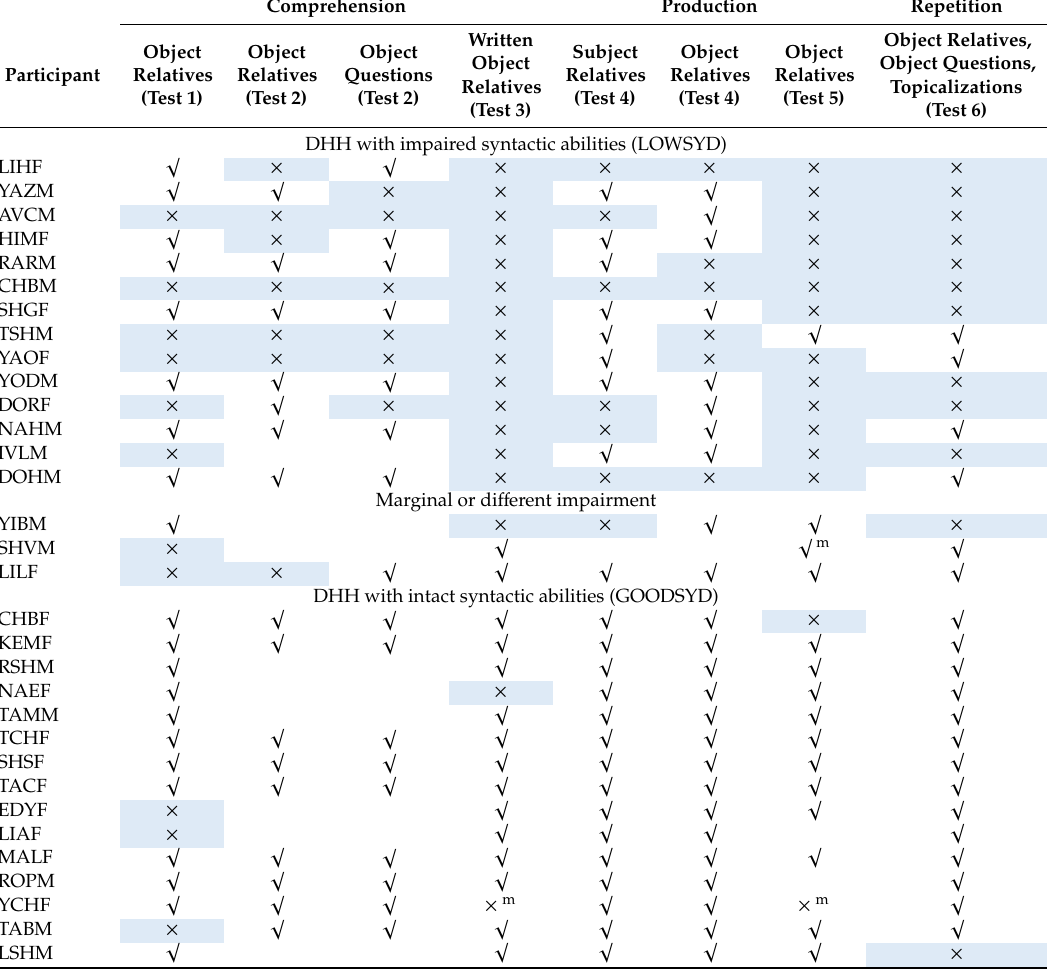
Table 2. Performance of each DHH participant in the syntactic tasks ( controls, × —significantly below the hearing